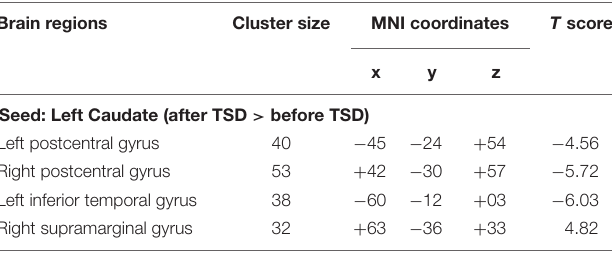
TABLE 2 | Changes in whole brain FC in the left Caudate before and after 36 h TSD, size of relevant regions, coordinates of MNI and maximum statistical t value ( n = 30).